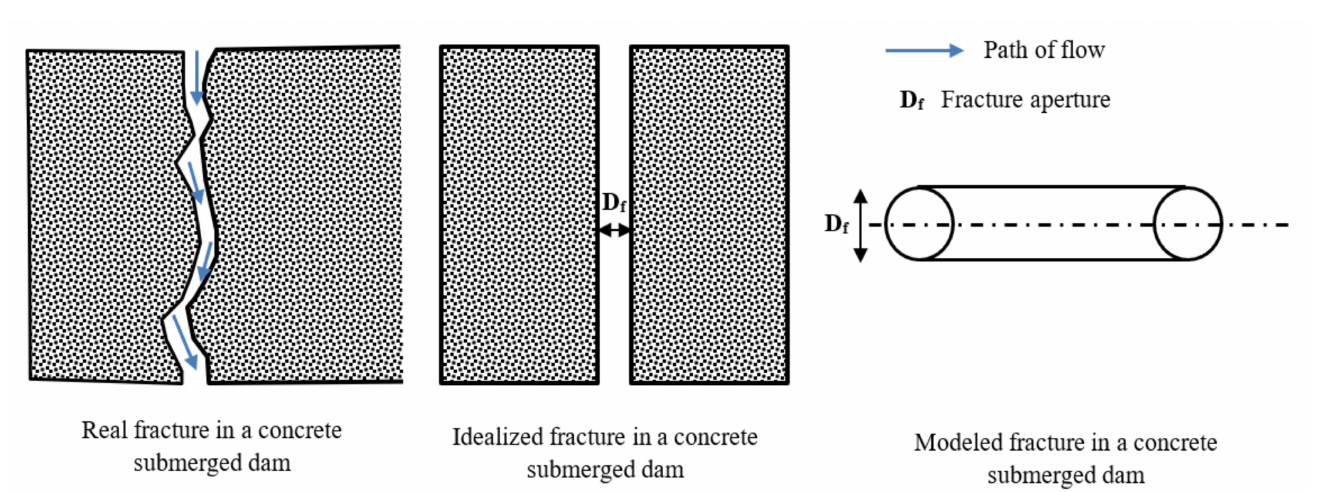
Figure 1. Real, idealized, and modeled fracture shapes in a concrete subsurface dam